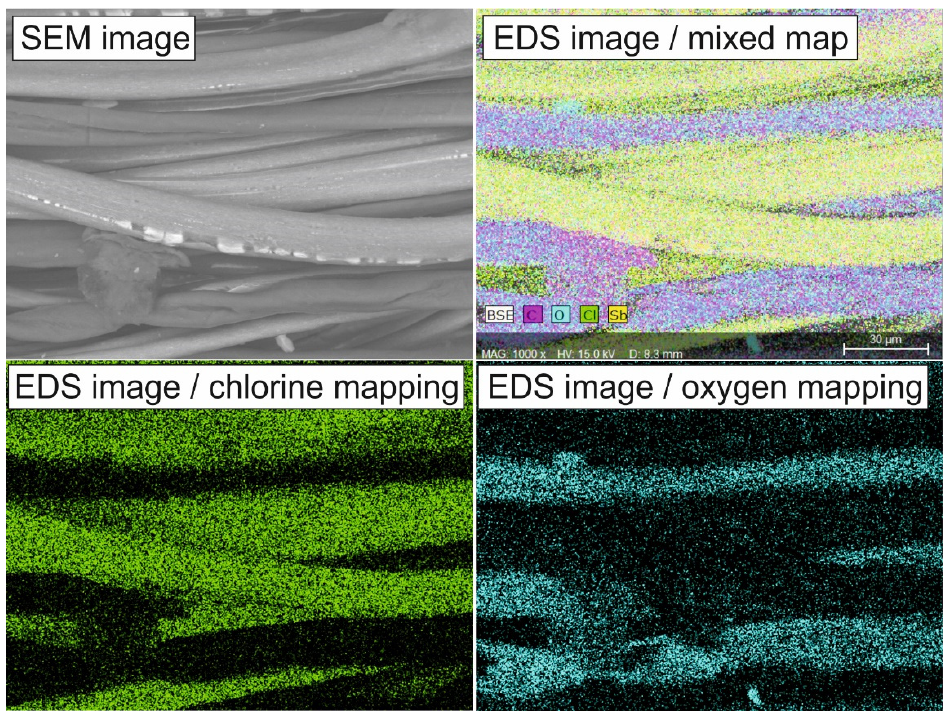
Figure 28. SEM image and related EDS images from a commercially available flame-retardant belt. The mappings for the chemical elements chlorine and oxygen are especially compared.